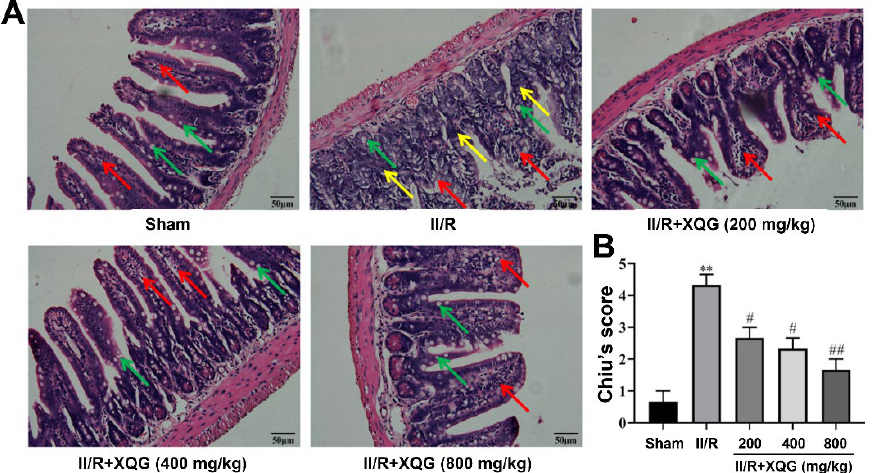
Figure 2. Protective effects of XQG against II/R-induced ileum morphological damage. ( A ) H&E staining of ileum histological lesion (scale = 50 μm). Goblet cells, lamina propria, and inflammatory cell infiltration were indicated by arrows with green, red and yellow colors, respectively; ( B ) Chiu’s score of ileum tissue. All values were expressed as mean ± SEM ( n ≥ 3). ** p < 0.01 vs. sham group while # p < 0.05 and ## p < 0.01 vs. II/R group.